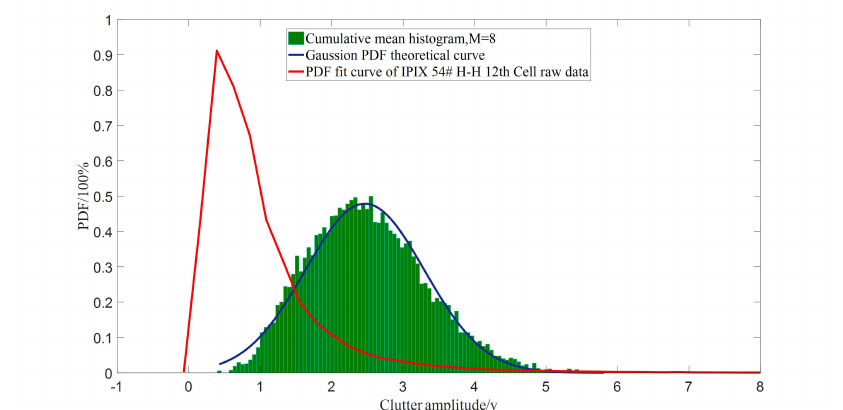
Figure 6. Statistical characteristics of 54 (cid:93) IPIX radar clutter before and after the accumulation and average processing.